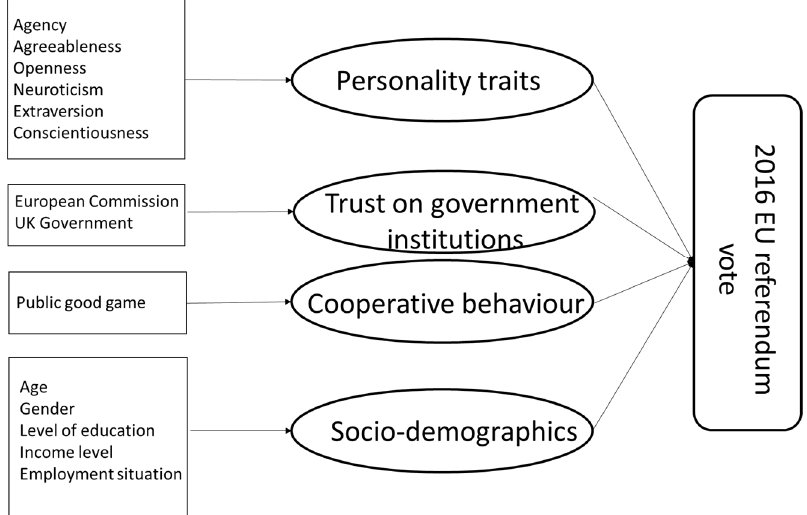
Figure 1. Conceptual